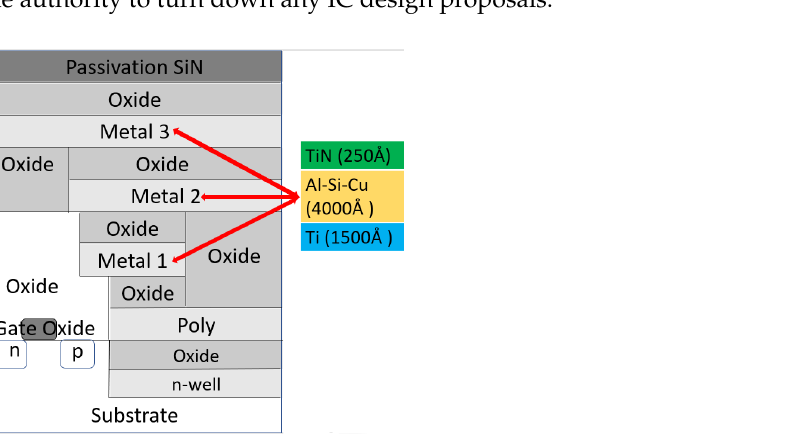
Figure 1. The structure layers of the 1P3M CMOS process provided by CIC and TSMC. Each metal structure is composed of TiN (barrier), Al-Si-Cu (conductor), and Ti (adhesion) [90].